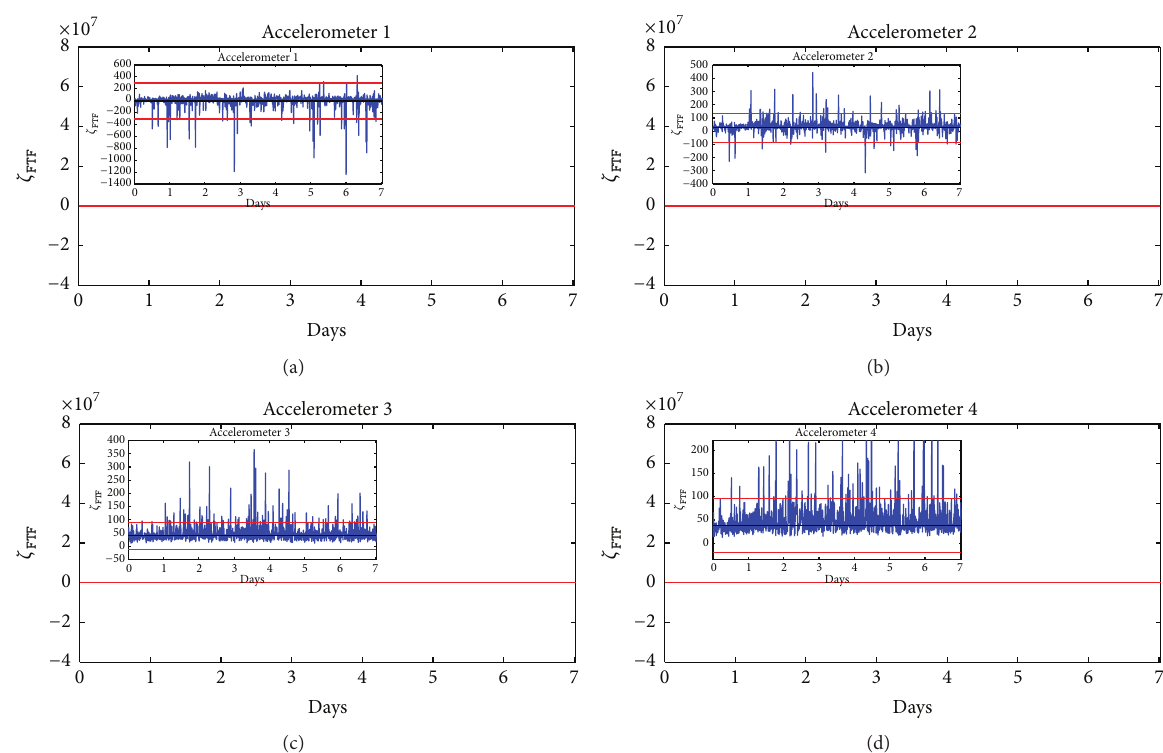
Figure 8: Damage indicators associated with the FTF frequency from each accelerometer.